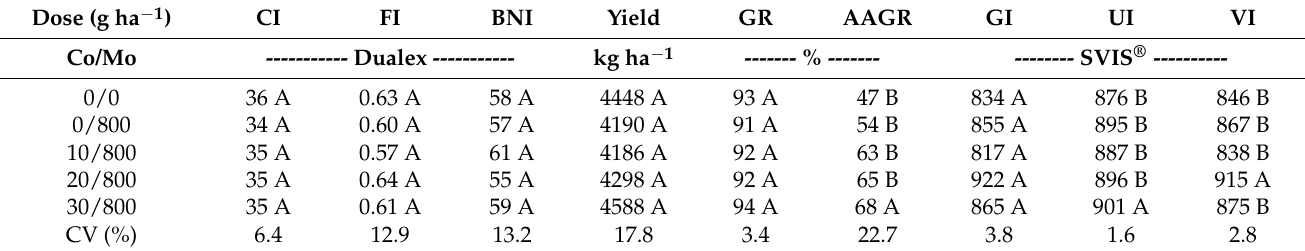
Table 3. Chlorophyll (CI), flavonoid (FI), and nitrogen balance indexes (BNI) of leaves, seed yield and germination rate (GR), accelerated aging germination rate (AAGR), growth index (GI), development uniformity index (UI), and vigor index (VI) of soybean seeds as a function of Co and Mo doses, applied to parent plants foliarly in the maturation phase, under field